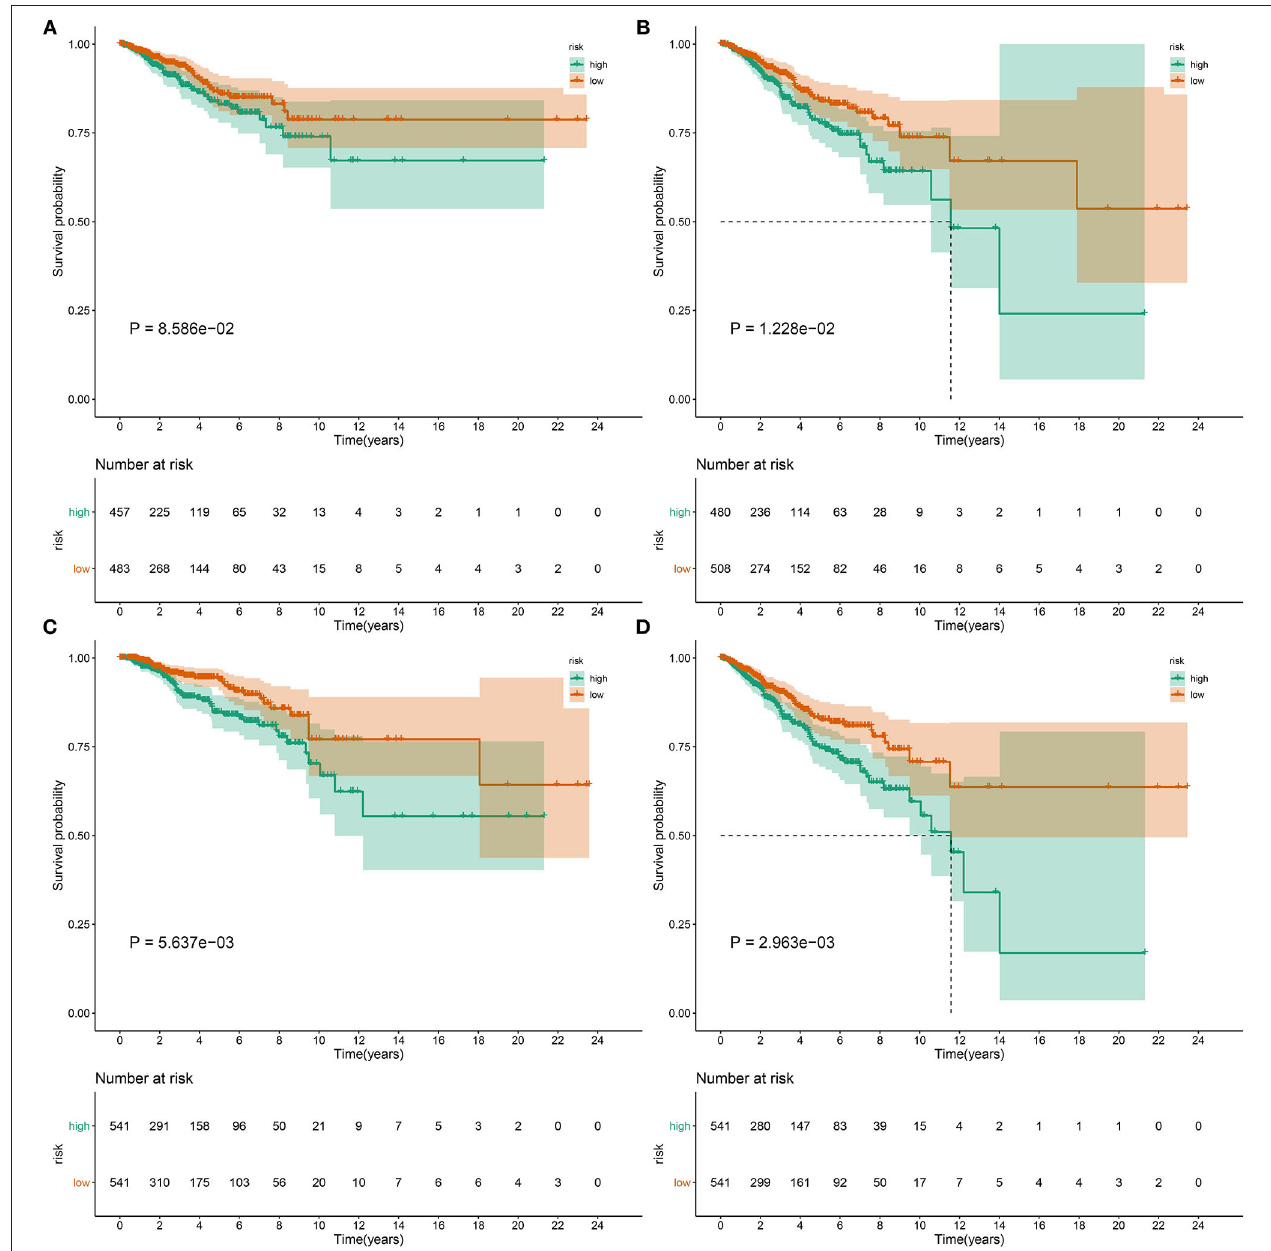
FIGURE 5 | The pyroptosis-related gene signature could predict progression and metastases of breast cancer. Differences in (A) DFI, (B) DFS, (C) DSS, and (D) PFI were compared in high- and low-risk samples by Kaplan-Meier curves and log-rank tests.